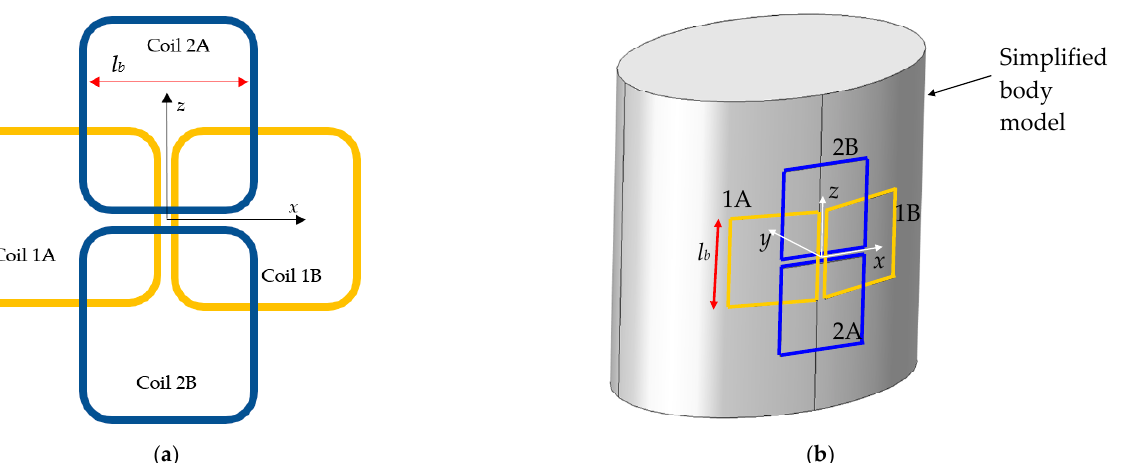
Figure 5. Magnetic flux line (in green) of DD coil with opposite mesh current directions ( a ) and identical mesh current directions ( b ).